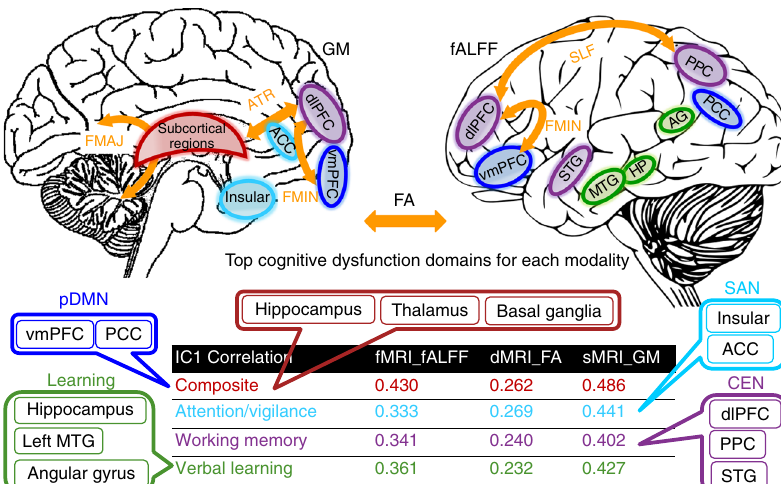
Fig. 4 Key neurocognitive networks and the correspondence with CMINDS cognitive domains. Loadings of the identi fi ed component (FBIRN_IC ref_composite ) are correlated with the cognitive composite score and multiple domain scores for each modality. Here, we listed the top three most correlated domains. The CMINDS domains are shown in the same color with its most correspondent brain networks; consequently, the brain regions in the top panel are demonstrated with the same color of its corresponding network. Left panel is GM, right panel is fALFF, FA is illustrated as orange arrows, MTG is middle temporal gyrus, PPC is posterior parietal cortex, PCC is posterior cingulate